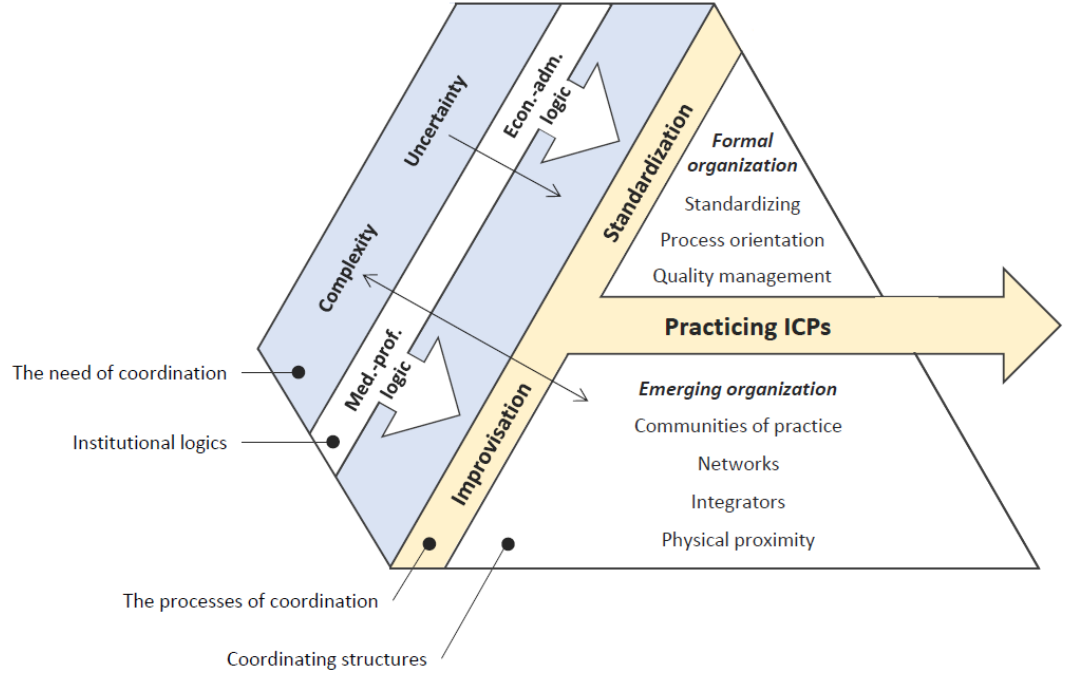
Figure 1. Relation and interaction between concepts.